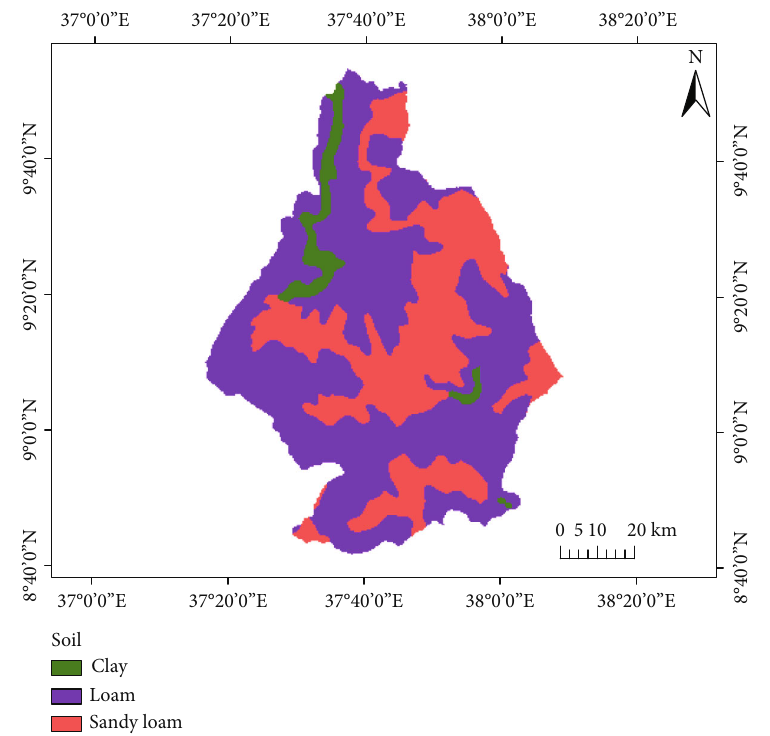
Figure 7: Soil type of the Guder watershed.